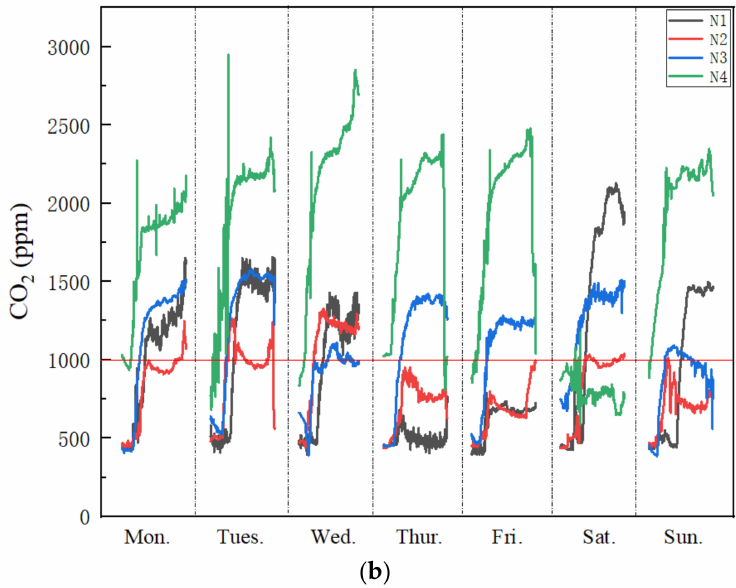
Figure 8. CO 2 measurement results. ( a ) Before heating, ( b ) After heating.